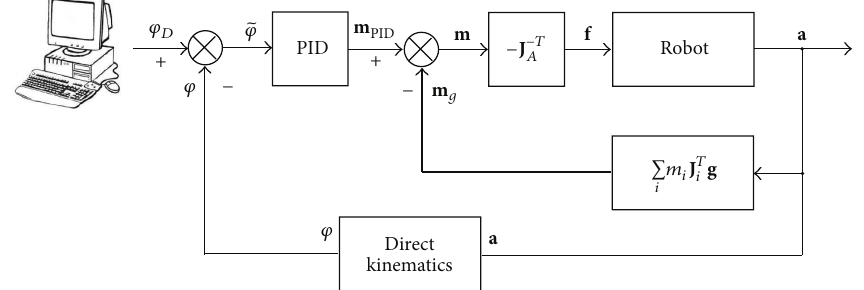
Figure 5: Task space PID controller with gravity compensation.